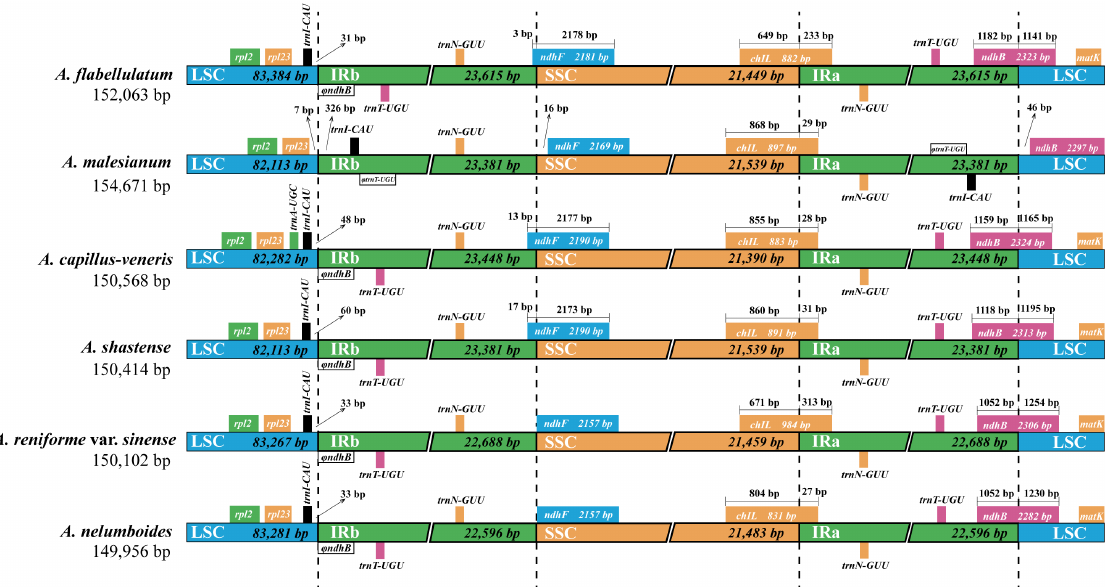
Figure 2. Analysis of the expansion/contraction of IR/SC boundaries in six Adiantum cp genomes. For each species, genes transcribed on the positive strand are depicted from right to left above the corresponding tracks, while genes on the negative strand are depicted from left to right below the tracks. Arrows indicate the distance from one side of the gene to the LSC/IR boundary. Φ ndhB is a partial copy of ndhB in the IRa. Φ trnT-UGU represents fragmented sequences of trnT-UGU . Expansion and contraction of IR/SC boundaries are generally considered to be the major factors inducing cp genome size change. This seems not to be the case in A. male- sianum . Cp genome comparison of the six species (Table 1) revealed that the size change of A. malesianum cp genome is caused by LSC rather than IRs, because A. malesianum has